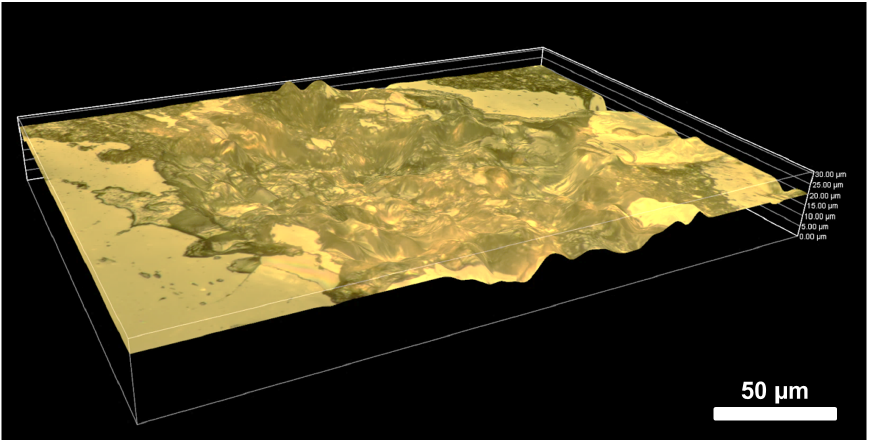
Figure 22. Example of a reflected light 3D step image of an LIBS crater in feldspar. The crater is not uniform or symmetrical, making an estimation of area or ablation volume challenging.